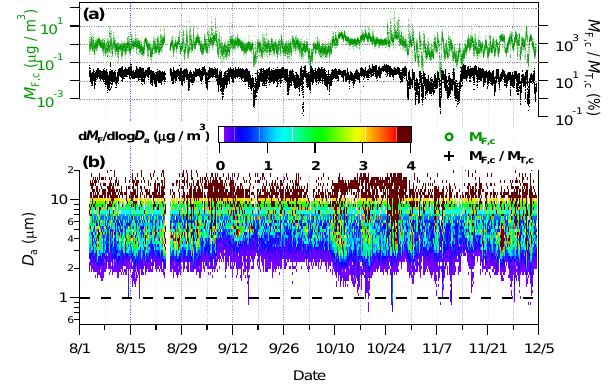
Fig. 4. Time series of FBAP mass concentrations and size distribu- tions for the entire measurement period. (a) Integrated coarse FBAP mass concentration (1–20 µm, M F , c ) on left axis (green) and FBAP fraction of TAP mass ( M F , c / M T , c ) on right axis (black). Note that axes are logarithmically scaled and off-set from one another. Each data point represents a five-minute measurement. (b) FBAP size distribution with date on x-axis, aerodynamic diameter on y-axis, and color scale of d M F /dlog D a with white values set to 0.1µgm − 3 for visual clarity. Dashed black line at 1.0µm shows particle size cut-off below which fluorescent particles were not considered FBAP due to interference with non-biological